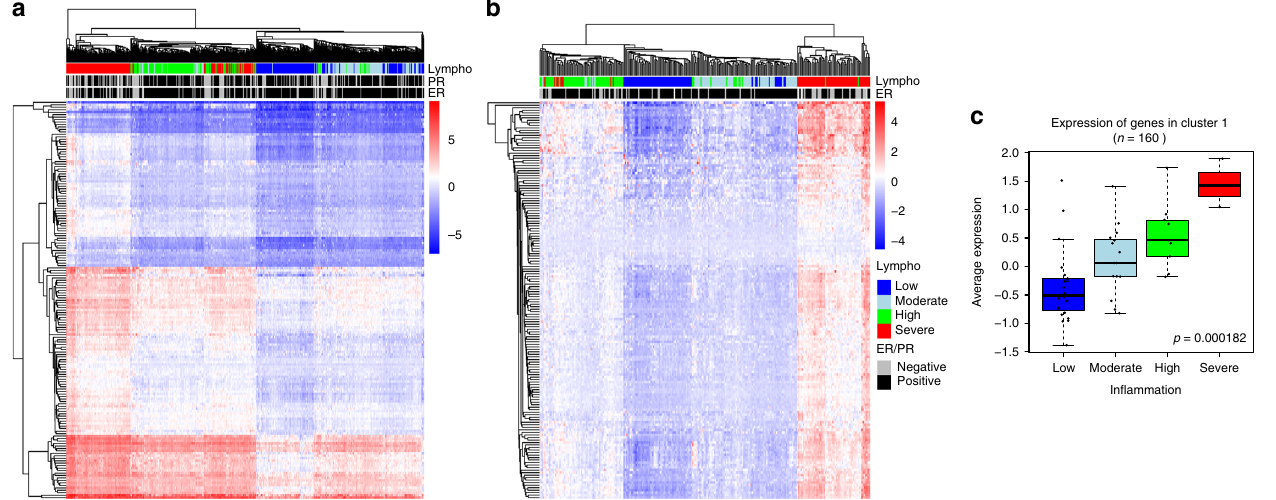
Fig. 8 Cluster 1 highlights a link between DNA methylation and lymphocyte in fi ltration. Unsupervised clustering of expression levels of the 160 genes in Cluster 1 from a the TCGA cohort ( N = 528) and b the OSL2 cohort ( N = 272). Annotations of the column indicate the level of lymphocytes in fi ltration, ER and PR status. Levels of lymphocyte in fi ltration were calculated from a set of genes expressed by lymphocyte characterized by the algorithm Nanodissect 34 . c 68 tumor tissue samples were scored as low ( n = 30), moderate ( n = 22), high ( n = 13) or severe ( n = 3) in fl ammation by a pathologist based on the level of immune cell in fi ltration found in each tumor. Boxplot representing average expression of genes in Cluster 1 ( n = 160) according to in fl ammation score. Kruskal – Wallis test p -value is